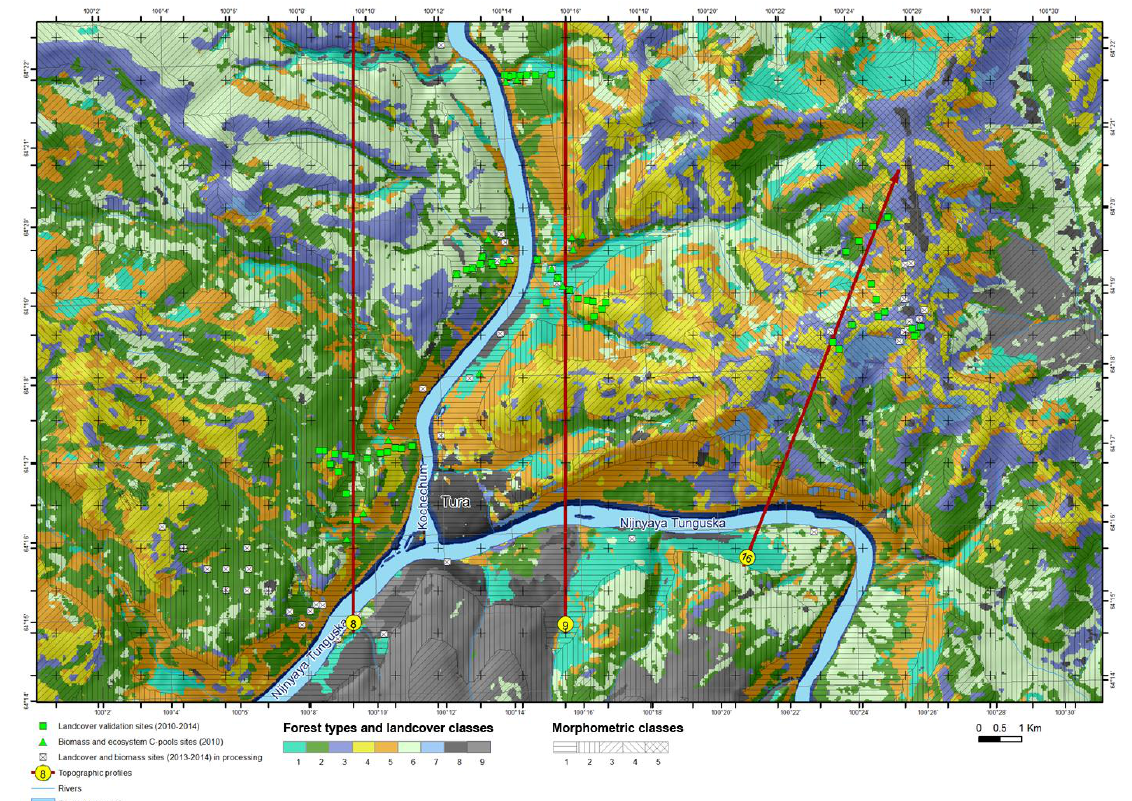
Figure 5. RS-based forest types layer overplayed by DEM-based morphometric classes for the fragment of test site